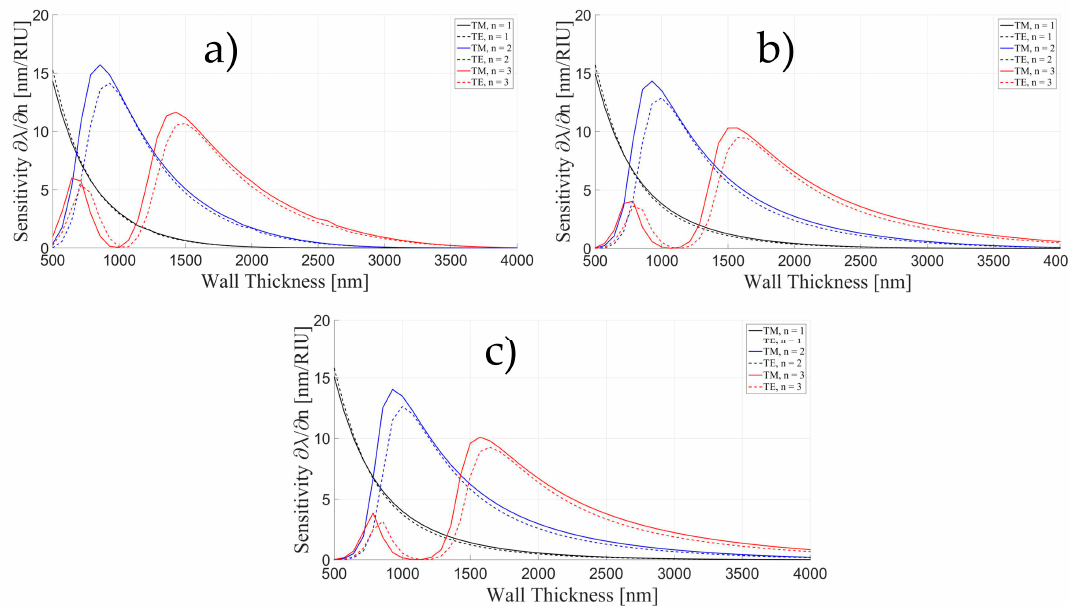
Figure 3. TE and TM mode sensitivity as a function of wall thickness for the first three radial orders and three different radii: ( a ) 50 μ m; ( b ) 150 μ m and ( c ) 250 μ m.